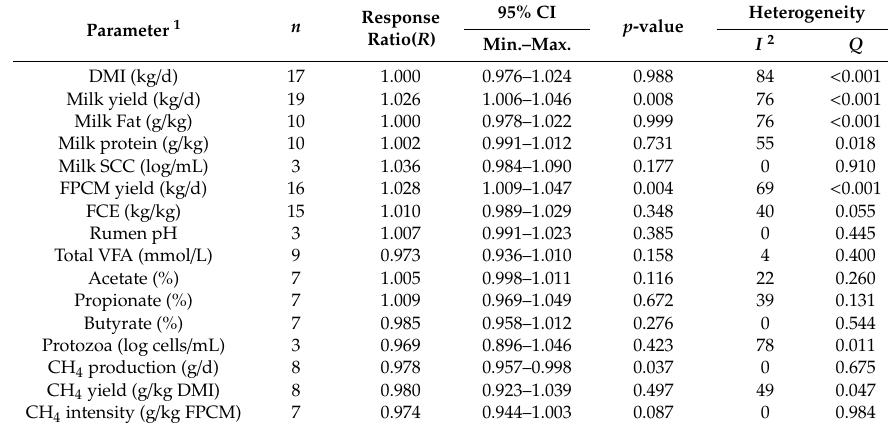
95% CI Heterogeneity Response p -value Ratio( R ) Min.–Max.